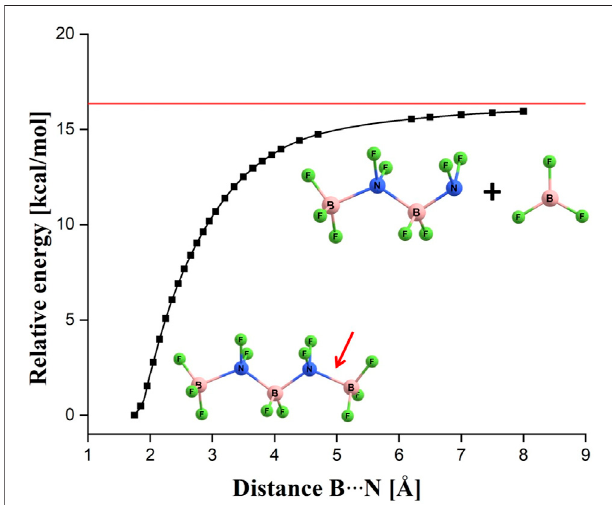
FIGURE 2 | Energy pro fi le corresponding to the relaxed scan along the terminal B-N bond (indicated by a red arrow) in the (BF 3 -NF 2 -BF 2 -NF 2 -BF 3 ) – anion. The horizontal red line indicates the sum of the energies of the isolated (BF 3 -NF 2 -BF 2 -NF 2 ) – and BF 3